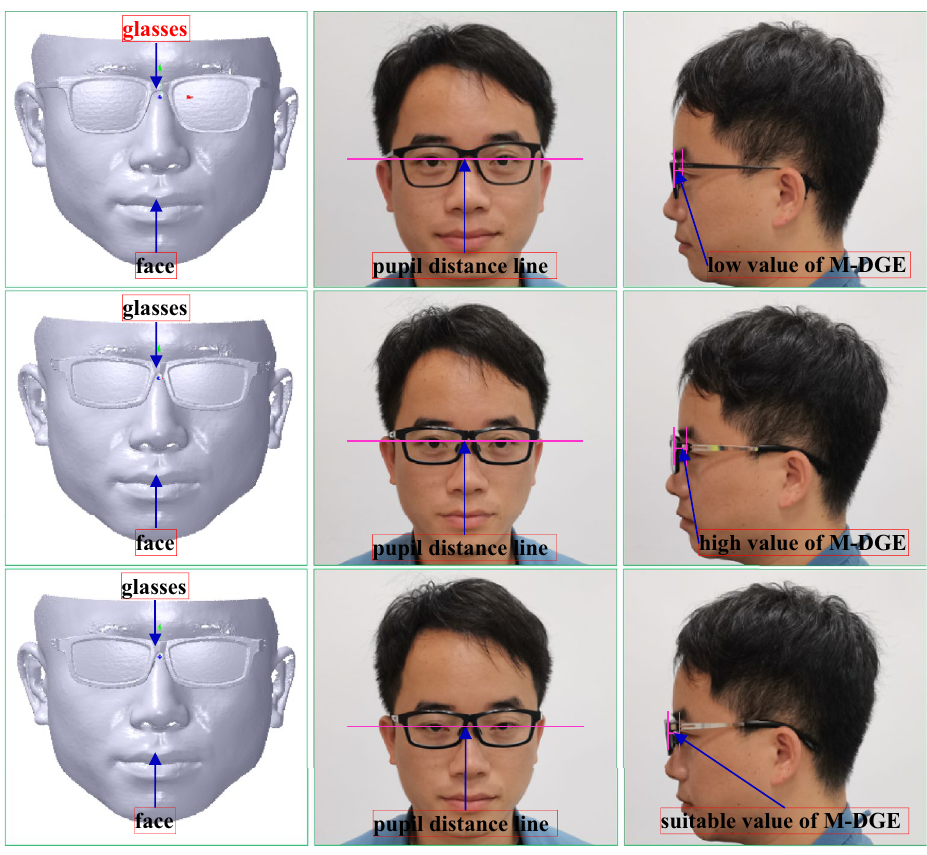
Figure 29. The try-on results of the myopic glasses of example 1. From left to right: the scanned face with glasses, the front view, the left view. From top to bottom: commercial glasses, the method of Liu 10 , our